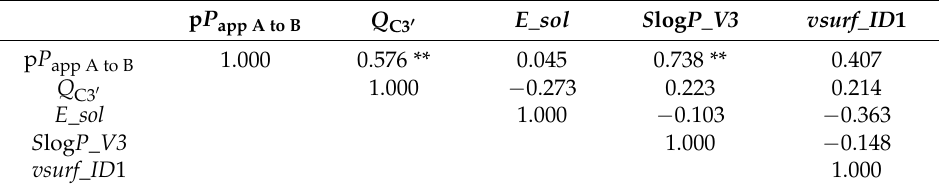
Table 6. The Pearson Correlation between p P app A to B and related descriptors.